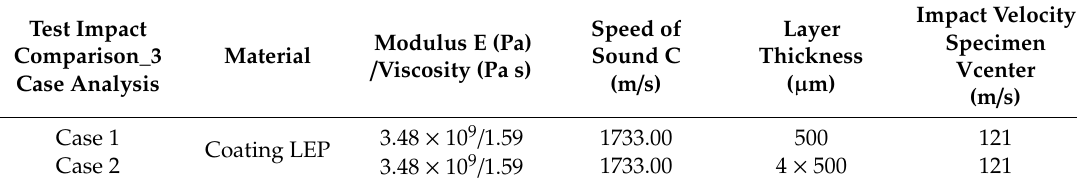
Table 2. Modelling input data for variation cases in Coating thickness